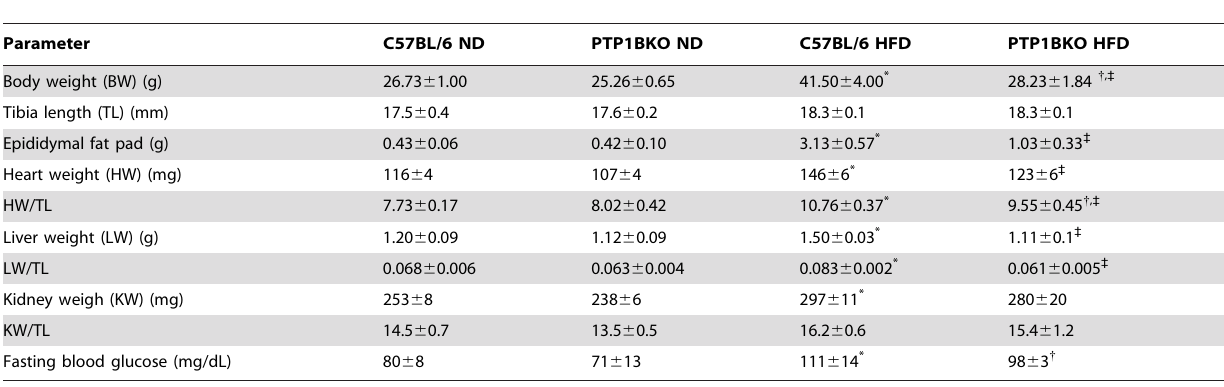
Table 1. Morphometry and fasting glucose of C57BL/6 and PTP1BKO female mice fed with a ND or a HFD for a 20 week period.